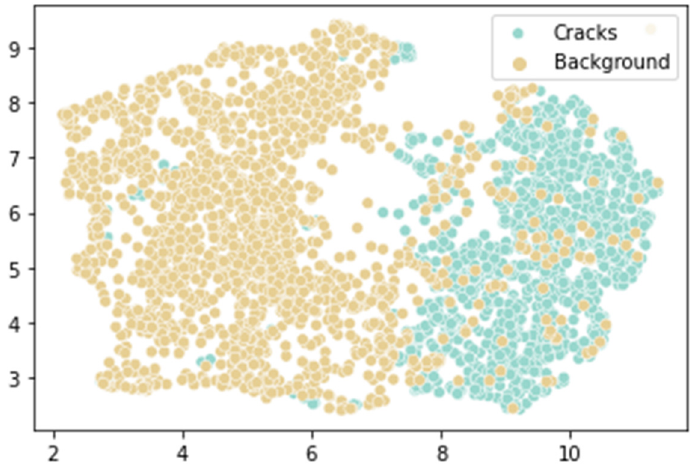
Figure 7. UMAP visualization map of HOG and ULBP features after KPCA application and feature fusion.